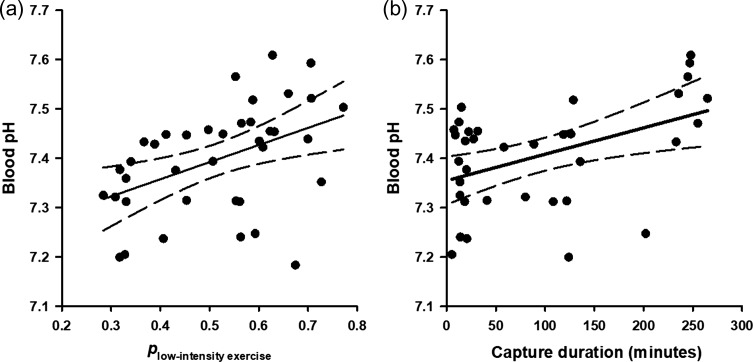
Relationship between exercise intensity (a) and capture duration (b) of longline-caught nurse sharks (Ginglymostoma cirratum) and physiological status. The proportion of time sharks exhibited low-intensity exercise (plow-intensityexercise) refers to periods of inactivity or resting. Proportion data were log-ratio transformed for analyses and were back-transformed for presentation. Dashed lines represent 95% confidence intervals.